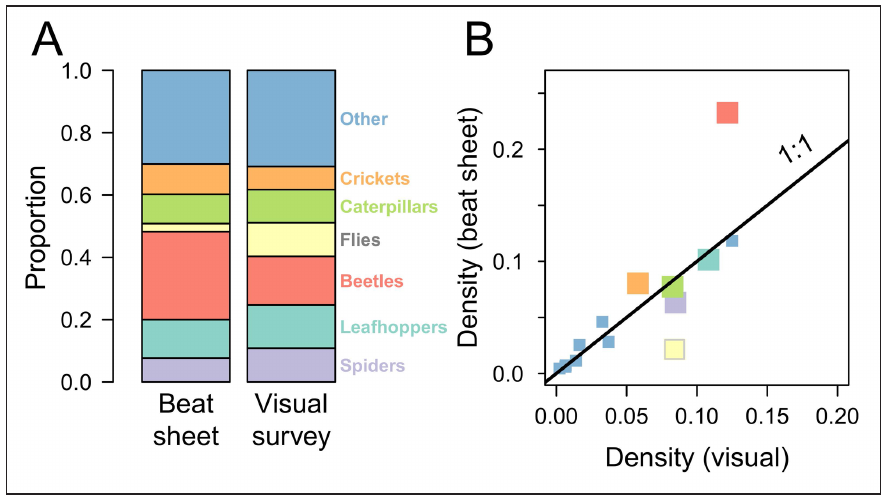
Figure 3: (a) Variation in the proportion of arthropod groups by survey methodology. (b) Comparison of absolute den- sity estimates of different arthropod groups based on survey methodology. Data were collected by trained scientists in both 2015 and 2016. (A comparison of caterpillar phenology observed by these two methods is presented in Figure